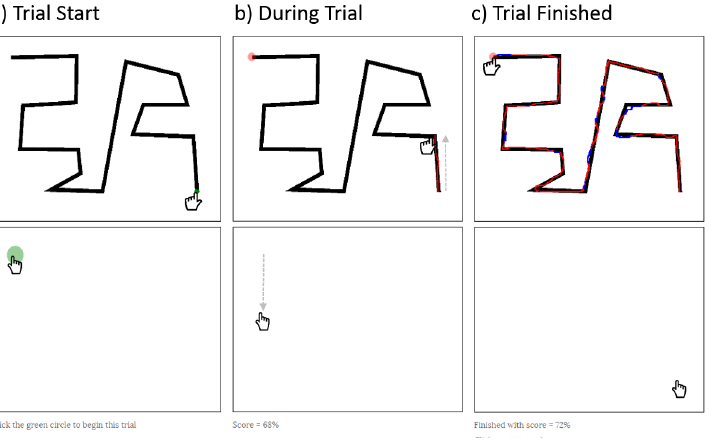
Fig 2. Online Mirror Tracing Task. The task displayed two rectangular canvases: the bottom canvas was the “ drawing pad ” where the participant actually moved the cursor; the top canvas was the “ mirror ” which showed an image of the figure to trace and which produced a mirrored-trail of the path of mouse movement on the drawing canvas. A) To start the task, participants moved the cursor into a green start box on the drawing pad and click the mouse. This caused the mirrored cursor to come into register with the beginning of the figure. B) Once the trial was initiated, all mouse movements within the drawing pad produced a colored, mirrored trail in the mirror. To illustrate, the dotted line shows the path of the cursor straight down in the drawing pad, the corresponding mirrored trail straight up in the mirror. The trail left is colored red when within the figure to trace, blue when within. The current score is shown just below the drawing pad. C) The trial finished when the red target is reached. In this case, the score achieved is 72%. Participants could move directly to the target, but this would yield a very low score. A demonstration of this task is posted online at: http://tinyurl.com/mirror-task; source code is posted to the Open Science Framework.